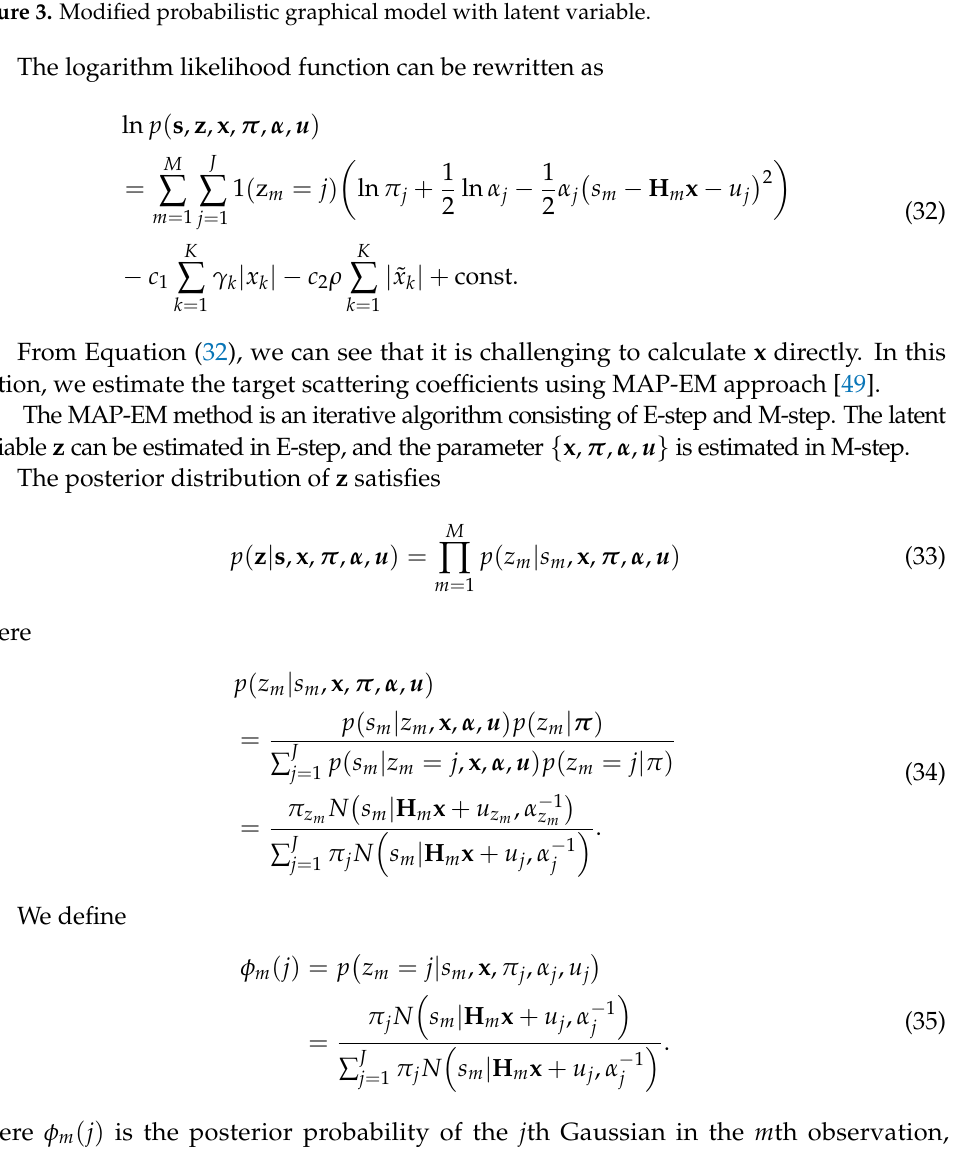
Figure 3. Modified probabilistic graphical model with latent